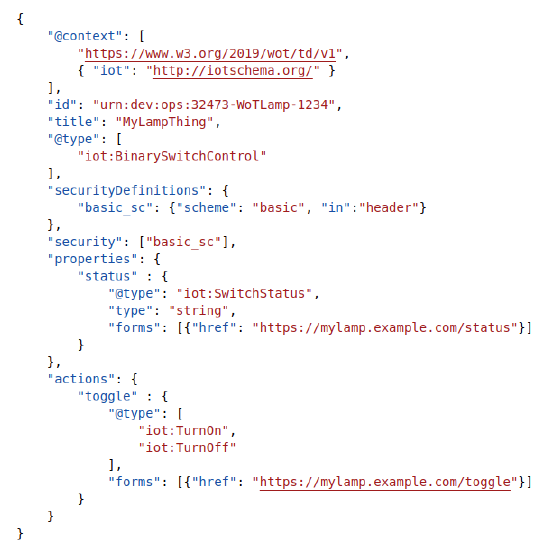
Figure 1. Thing description with interaction affordances.